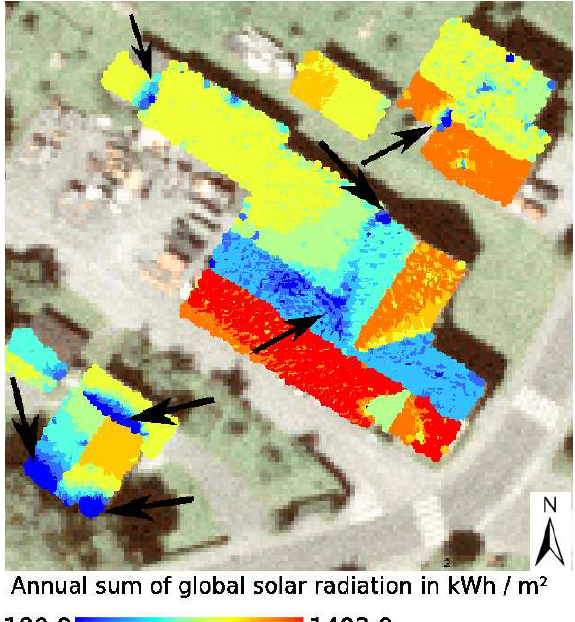
Figure 10. Point cloud view of detected roof planes together with objects possibly casting a shadow (a) and results of solar potential assessment for selected roof planes (b).